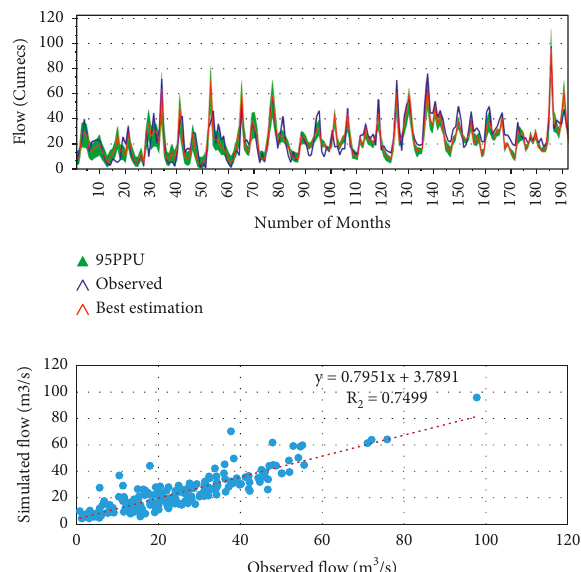
Figure 9: Scatter plot and monthly calibrated flow hydrograph at the Awata station.